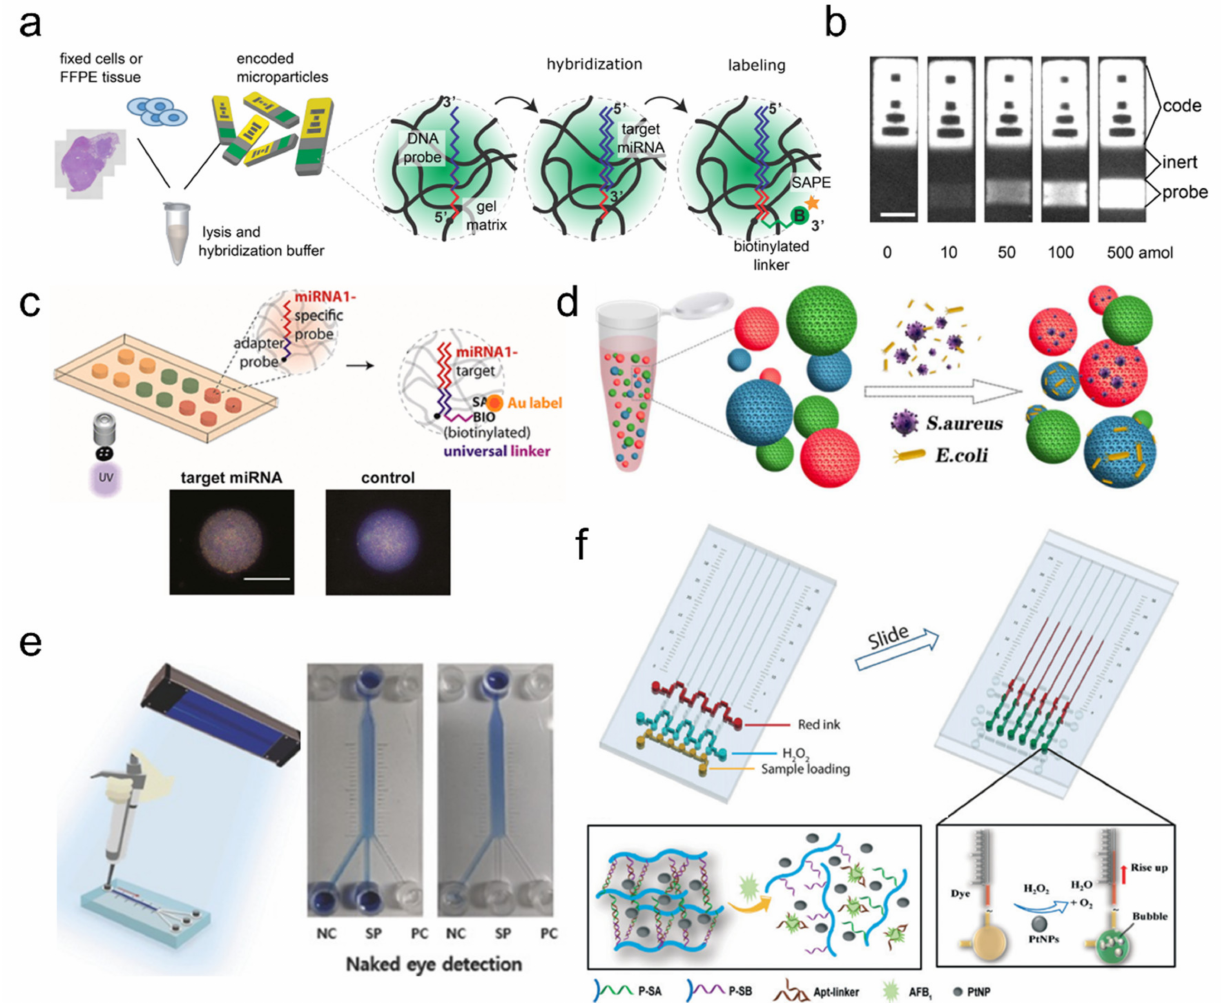
Figure 2. Nucleic acid-based biosensors. ( a – d ) Multiplex analyte detection using encoded hydrogel particles integrated with DNA probe. ( a , b ) Multiplexed miRNA detection using graphically encoded hydrogel microparticles; adapted with permission from [22]. Copyright 2018 ACS. ( c ) Multiplexed miRNA detection using spatially encoded hydrogel microparticles. Scale bar is 100 µ m; reproduced with permission from [24]. Published under CC-BY license 2020. Copyrighted by the authors. ( d ) Mul- tiplexed pathogen detection using colorimetrically encoded hydrogel microparticles. Microparticle colors indicate photonic reflectance barcodes; adapted with permission from [26]. Copyright 2018 El- sevier. ( e , f ) DNA hydrogel-based analyte detection using pure DNA hydrogel formation ( e ) or hybrid DNA hydrogel ( f ). ( e ) Rapid diagnosis of MERS pathogens using pseudo-serum sample; adapted with permission from [12]. Copyright 2016 Wiley. ( f ) Colorimetric detection of Aflotoxin B1-responsive aptamer hydrogel; adapted with permission from [27]. Copyright 2016